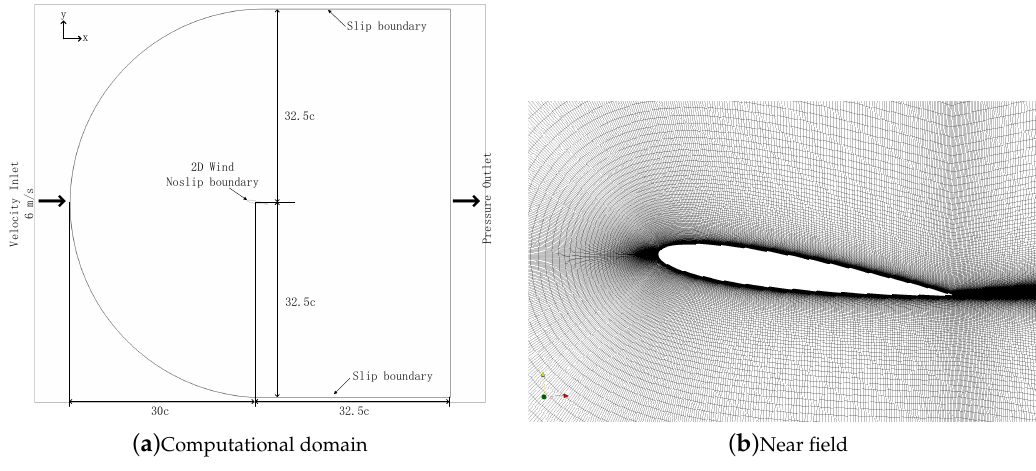
Figure 10. The computational domain and near mesh of 2D NACA0012 airfoil.